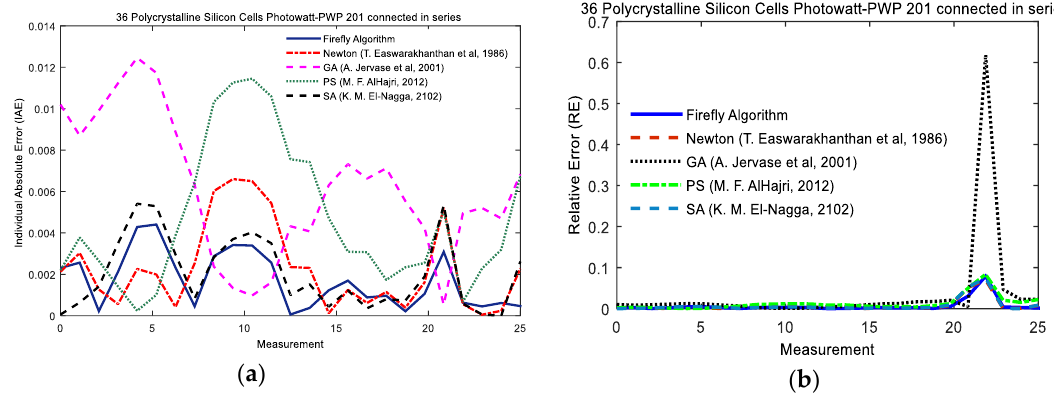
Figure 12. Comparison between, ( a ) IAE and ( b ) RE using the extracted parameters by FA and Newton-Raphson, PS, GA and SA for photovoltaic module Photowatt-PWP 201. In order to validate the optimal values